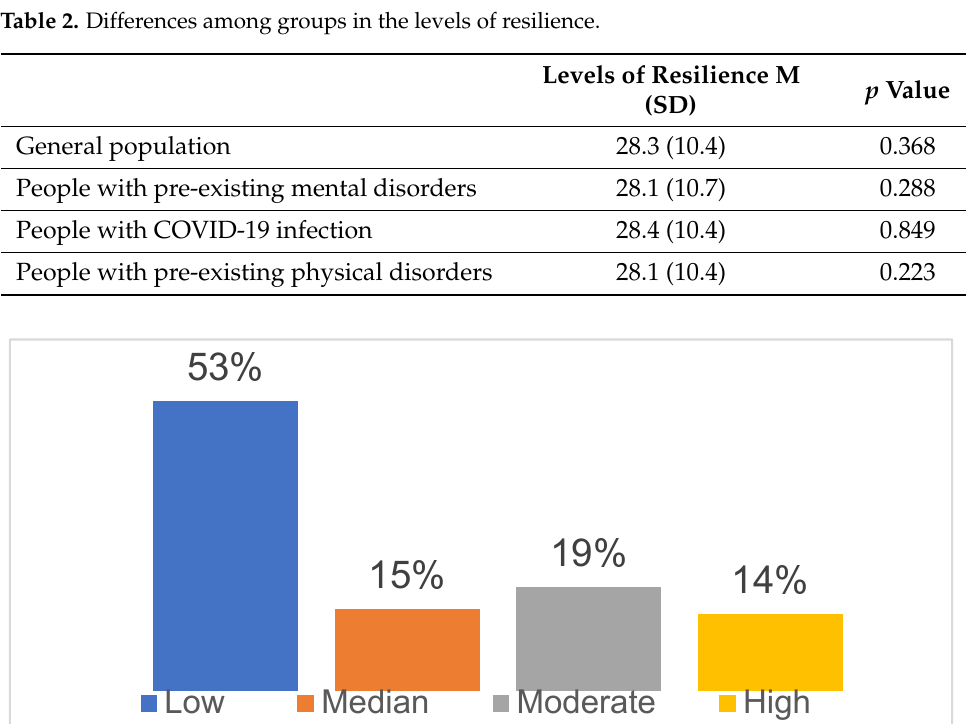
Figure 1. Levels of resilience in the global sample ( n = 20,270).